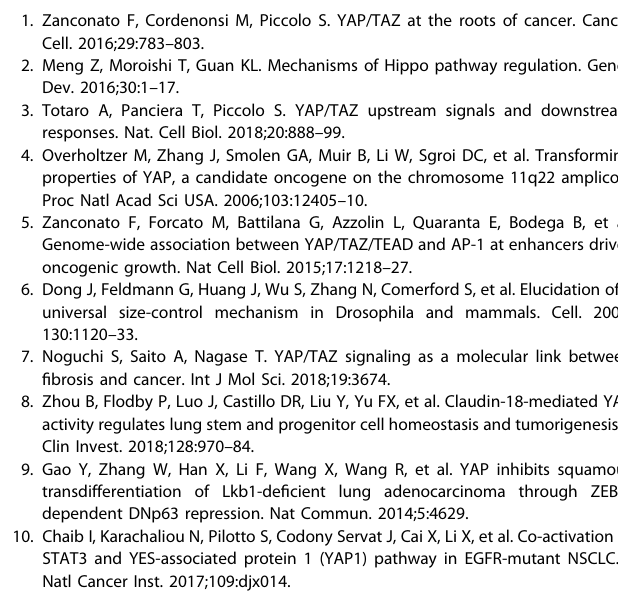
Fig. 7 Clinical association among YAP ISGylation, YAP, and 6PGL. A YAP protein level in LUAD and adjacent normal tissues as measured by ELISA. B 6PGL mRNA level in LUAD and adjacent normal tissues as measured by qPCR. C Association between YAP protein and 6PGL mRNA level. D Co-IP experiments analyzing YAP ISGylation in LUAD and adjacent normal tissues, and YAP and 6PGL expression in Input sample were analyzed by IB. The YAP level in each co-IP sample was adjusted to the same protein content. E , F Association between YAP bound ISG15 intensity and YAP intensity ( E ), as well as YAP, bound ISG15 intensity and 6PGL intensity ( F ) in LUAD tissues. G , H YAP protein and 6PGL mRNA level in stage I – III LUAD samples ( G ), <3 cm and >3 cm diameter LUAD samples ( H ). I Survival analysis for LUAD patients with high or low YAP protein and 6PGL mRNA level. J YAP protein and 6PGL mRNA level in high and low glucose LUAD samples. K Co-IP experiments analyzing YAP ISGylation in high and low glucose LUAD tissues, and YAP and 6PGL expression in Input sample were analyzed by IB. The YAP level in each co- IP samples was adjusted to the same protein content. L , M Association between YAP bound ISG15 intensity and YAP intensity, as well as YAP, bound ISG15 intensity and 6PGL intensity in high ( L ) or low ( M ) glucose LUAD tissues. The data are shown as the mean ± SD from three biological replicates (including IB). Data in A , B , H , I were analyzed using a student ’ s t test. Data in C , E , F , L , M were analyzed using the Spearman rank correlation analysis. Data in G were analyzed using a one-way ANOVA test. Data in I were analyzed using a log-rank test. ** P <